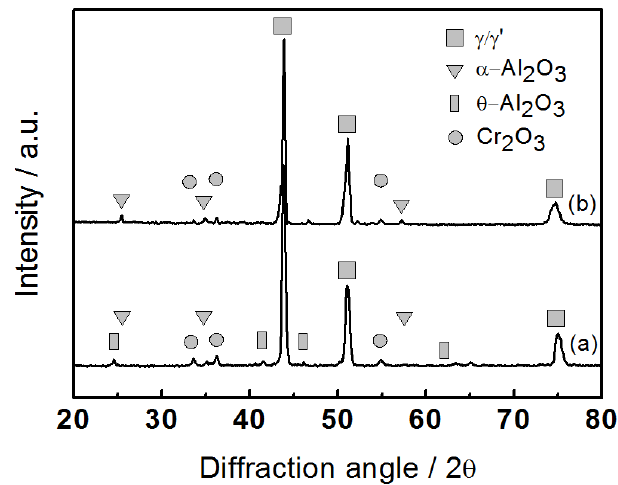
Figure 4. XRD spectra of the bondcoat samples after oxidation for 1 h at 1200 °C ( a ) as-sprayed sample, ( b ) Al coated sample.